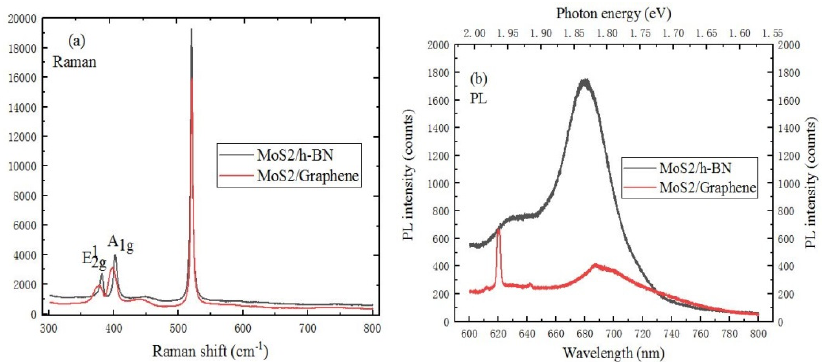
Figure 7. Spectral characteristics of MoS 2 on h-BN and graphene substrate ( a ) Raman spectrum (10 mW, 633 nm), ( b ) PL spectrum (20 mW, 633 nm).